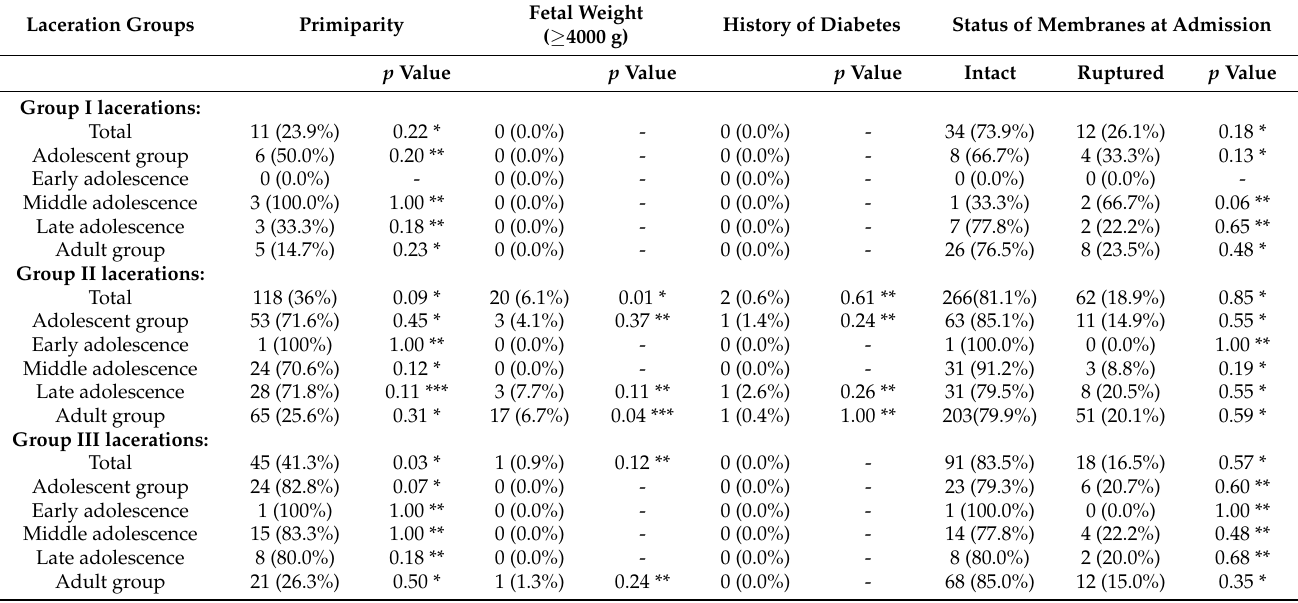
Table 3. Correlations between risk factors for obstetrical perineal tears and laceration groups. Laceration